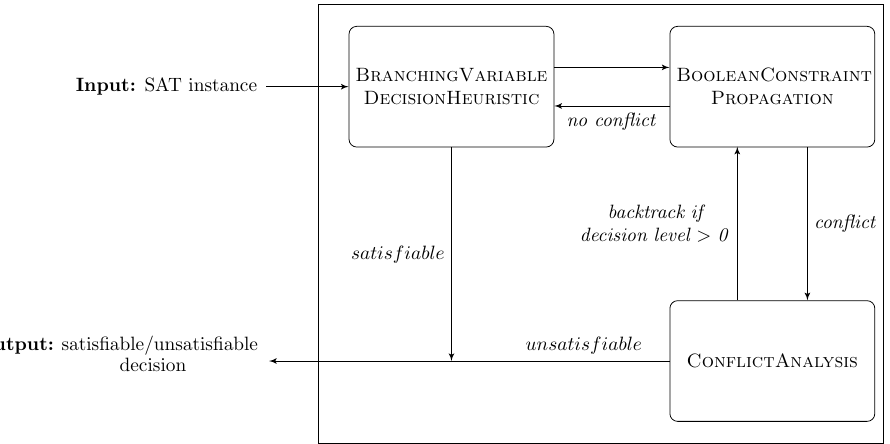
Figure 1. A general framework for CDCL-based SAT